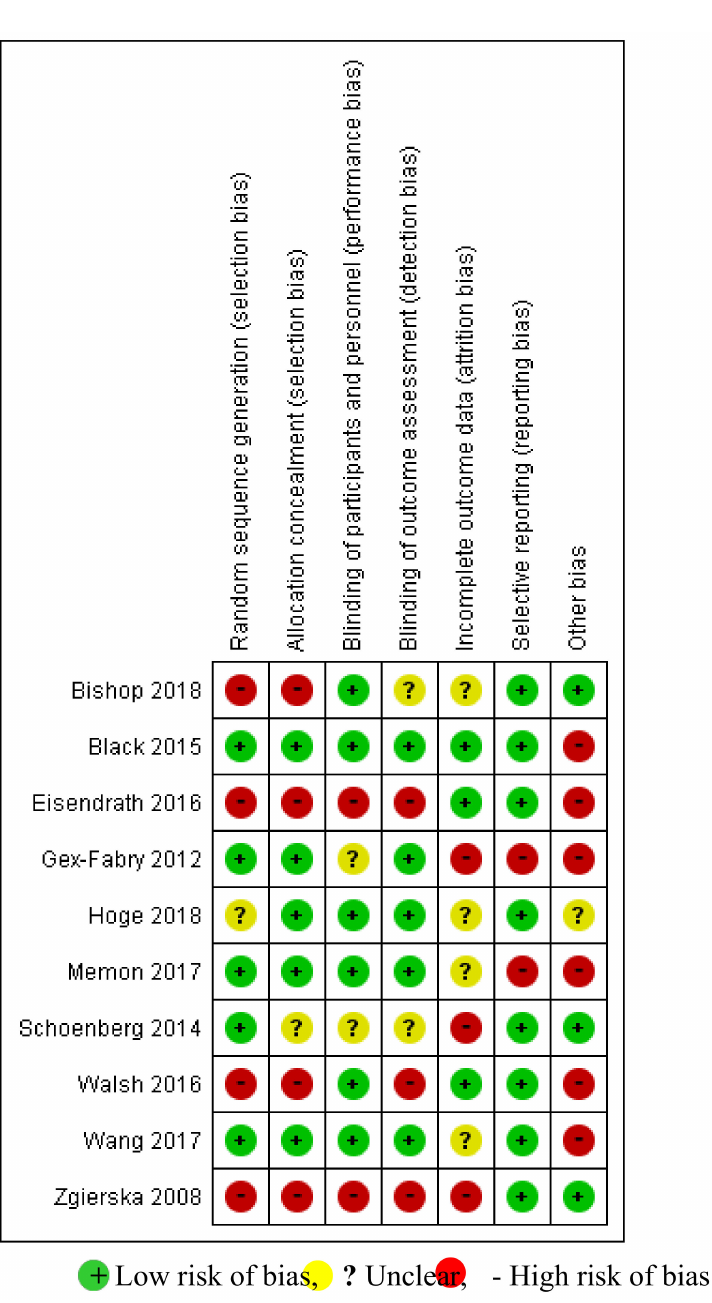
Figure 3. Risk-of-bias summary: review of the authors’ judgments about each risk-of-bias item for each included